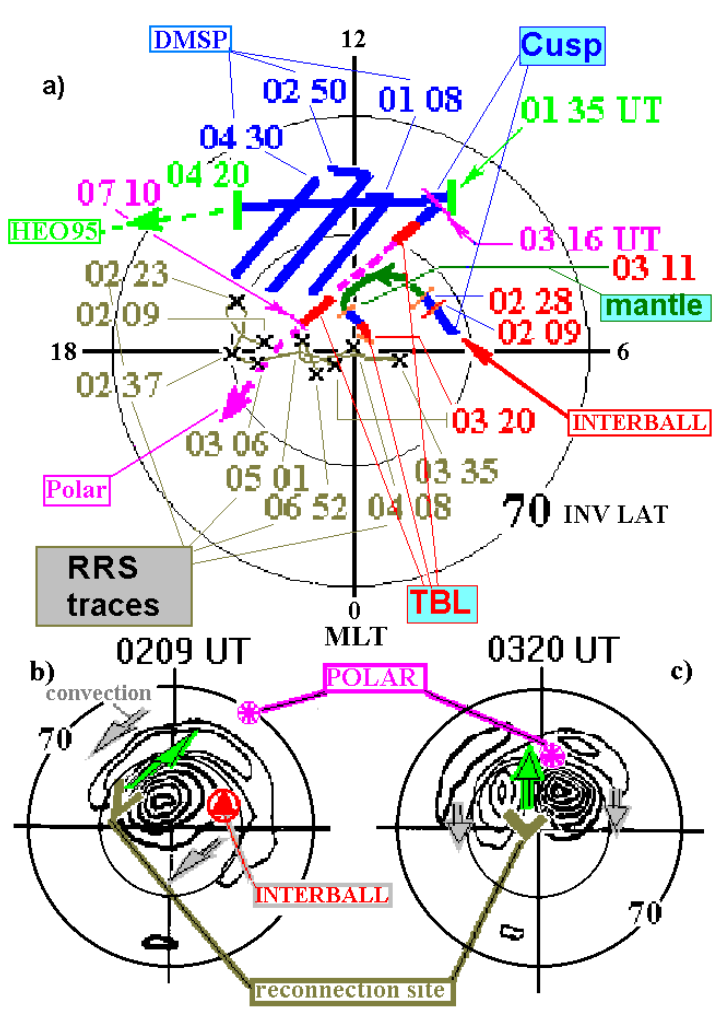
Fig. 7. Projection onto the northern ionosphere in (Invariant Latitude/ MLT) coordinates on 29 May 1996. (a) Cusp (blue), mantle (green), TBL (red) ionospheric traces for differentUT and spacecraft, marked in the figure and the traces of remote reconnection sites (RRS) for differentUT from the global MHD model (inclined crosses) (b) ionospheric equipotential contours for a cross-cap potential of 6kV and field-aligned current of 410 − 6 A/m. at 02:09UT from the global MHD model and (c) the same for 03:20UT. Traces of Polar (violet asterisks), Interball-1 (red circled triangle) and reconnection point footprints (RRS, brown arrows) are depicted along with the convection directions (along the contours, green arrows in the center and gray ones at the